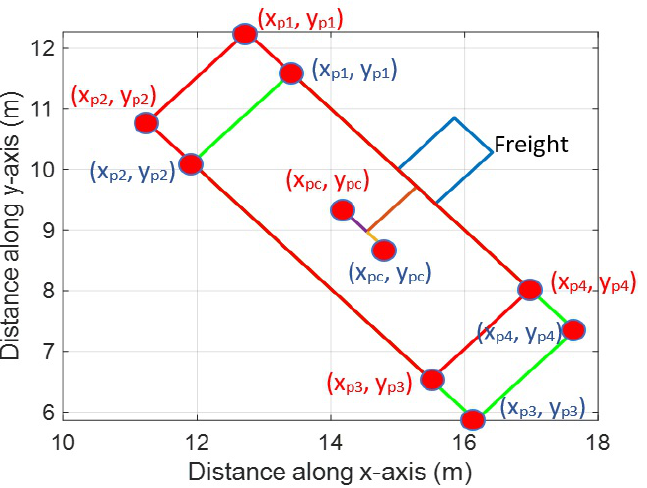
Figure 10. Parking spot with respect to loading